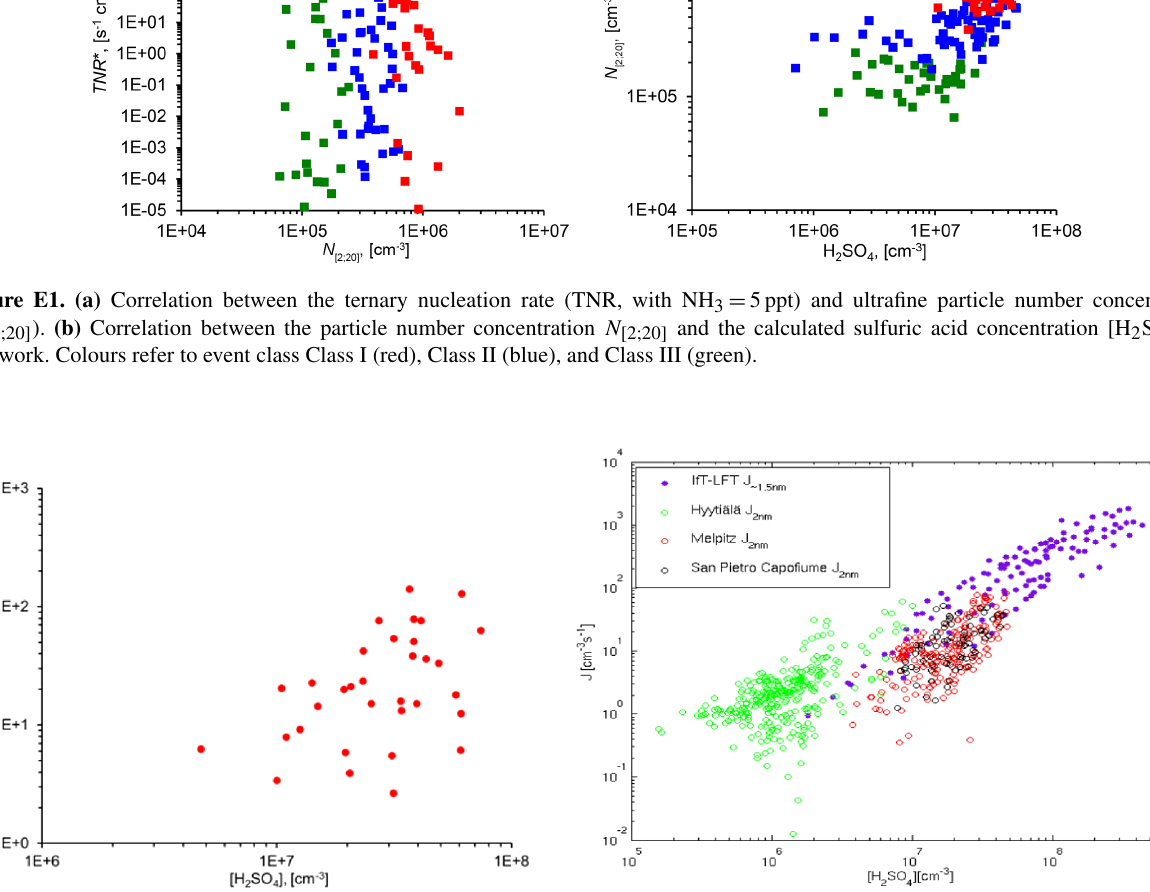
Figure E2. Left: correlation between the particle formation rate J 2 and the calculated sulfuric acid concentration [H 2 SO 4 ] in this work. The diagram involves 33 cases of NPF events between 2008 and 2011. Right: the same relationship from Kerminen et al.